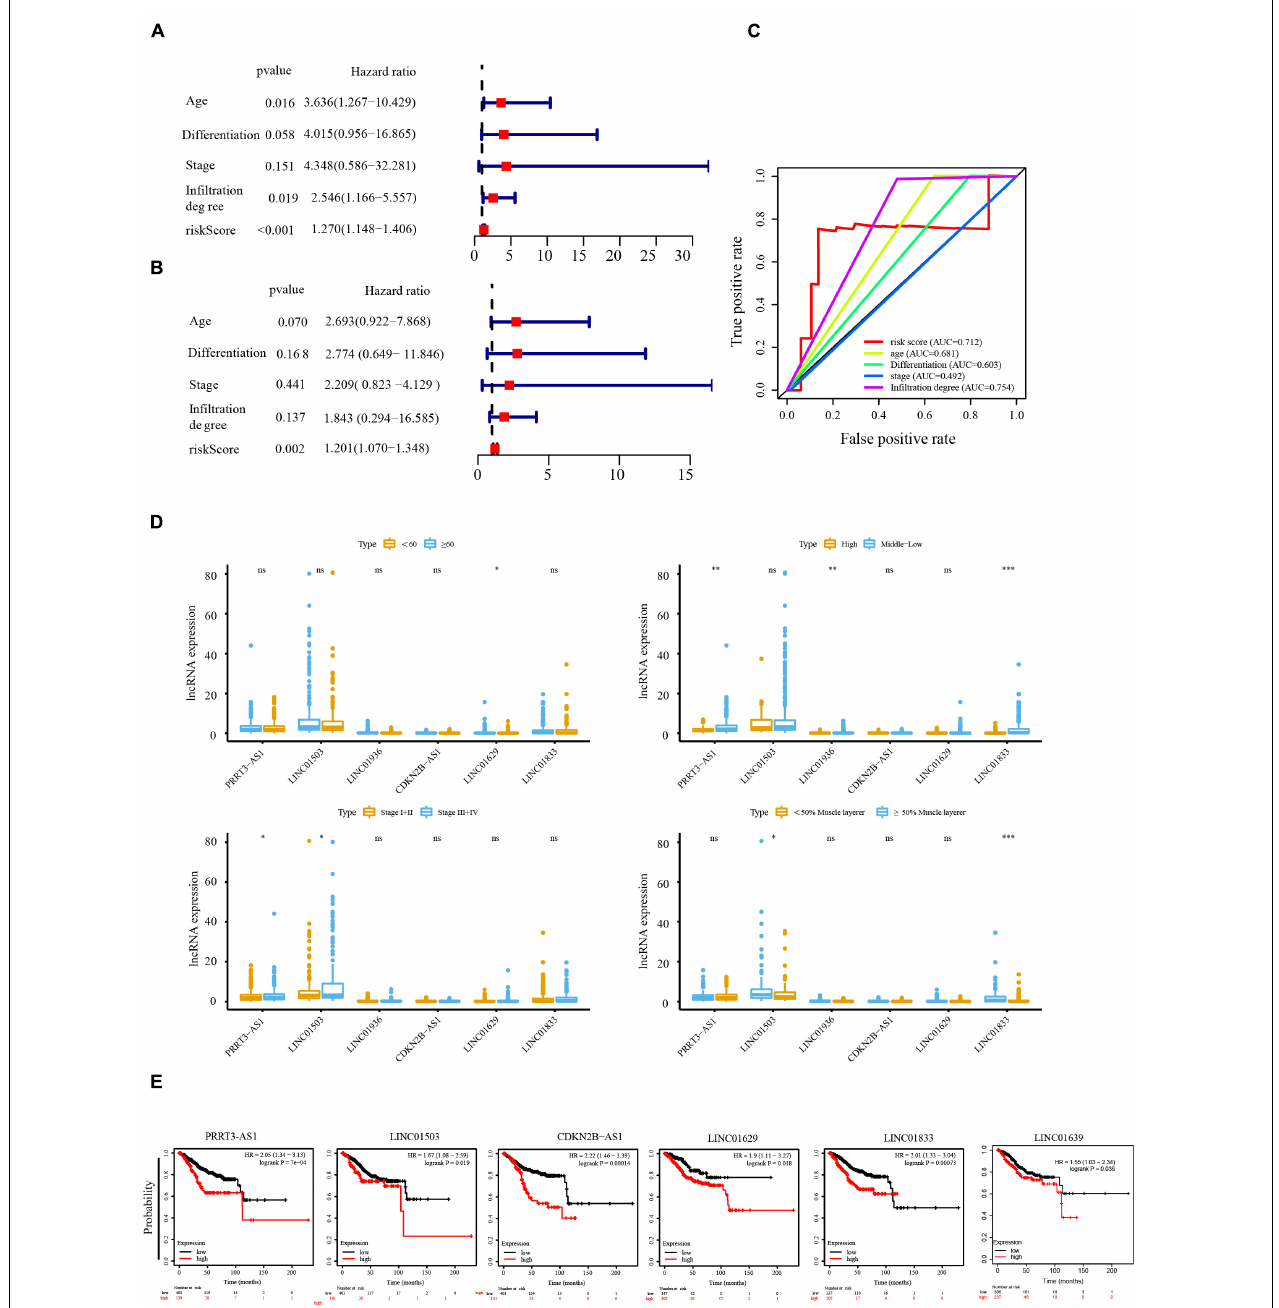
FIGURE 4 | Cox regression analysis of the independent prognostic value of the risk score. Univariate (A) and multivariate (B) Cox regression analysis of risk score, age, clinical stage, tumor differentiation, and depth of invasion. (C) The AUC of risk score, age, clinical stage, tumor differentiation, and depth of invasion was calculated from the total survival risk score according to the ROC curve. (D) Relationship between lncRNA expression and age, clinical stage, tumor differentiation, and depth of invasion. (E) Prognostic value of PRRT3-AS, LINC01503, CDKN2B-AS, LINC0162, LINC0183, and LINC01936 in UCEC analyzed using Kaplan–Meier (KM) Plotter. * P < 0.05, ** P < 0.01, *** P <